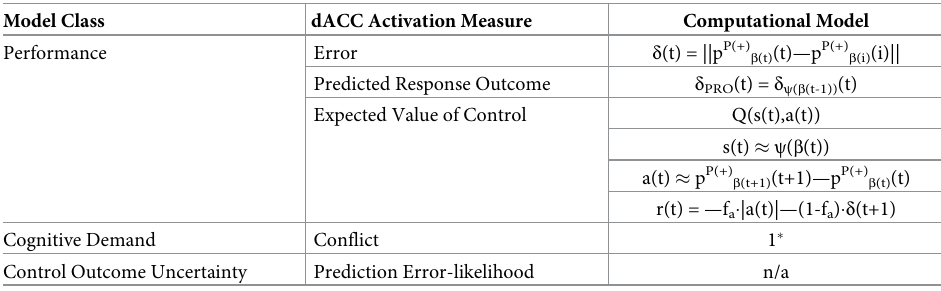
Table 1. Summary of cognitive control models of dACC